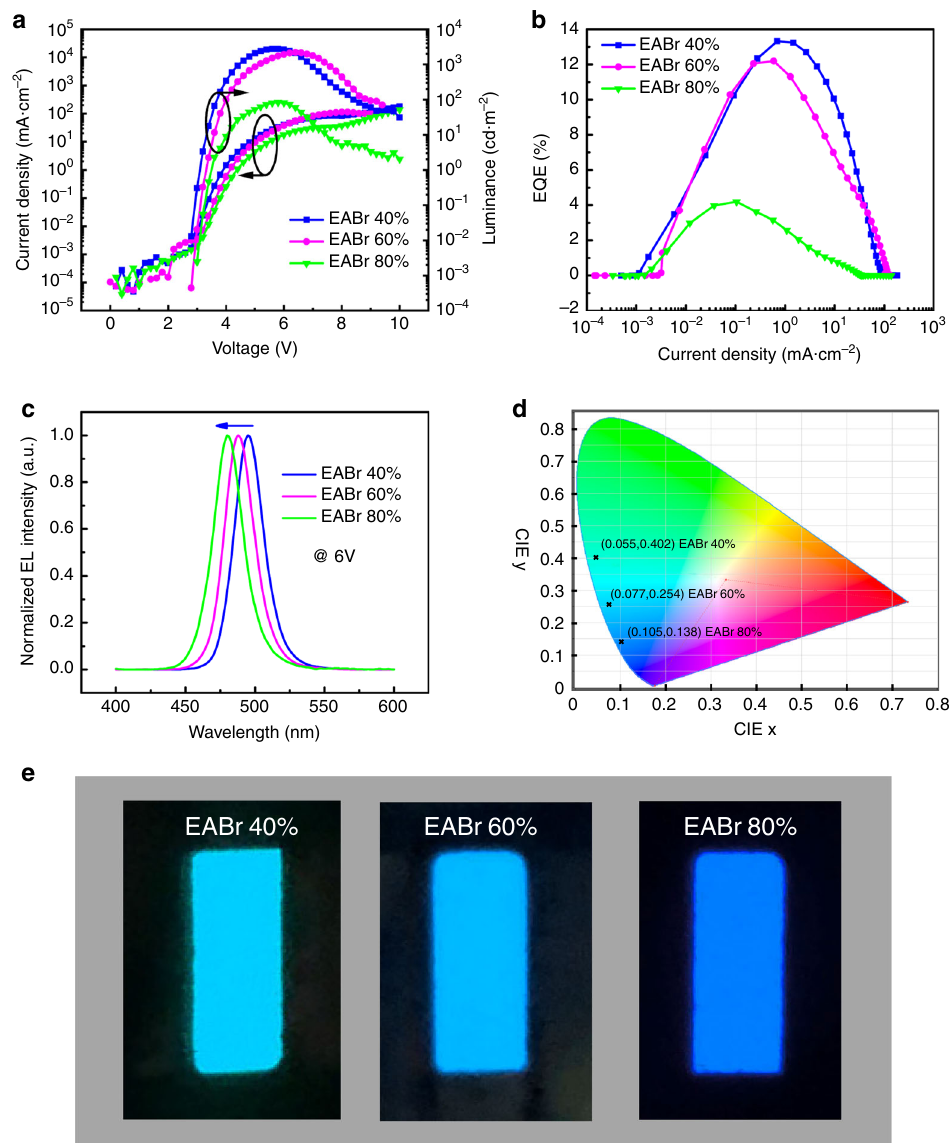
Fig. 4 Performance of the PeLEDs with different ratio of EABr. a Characterization of current density and luminance versus applied voltage. b Characterization of external quantum ef fi ciency (EQE) versus current density. c Normalized electroluminescence (EL) spectra of perovskite LEDs with 60% EABr under increasing applied voltage. d Commission Internationale de l ’ Eclairage (CIE) values of the EL spectra of perovskite LEDs. e Electroluminescence images of the perovskite LEDs with different EABr.